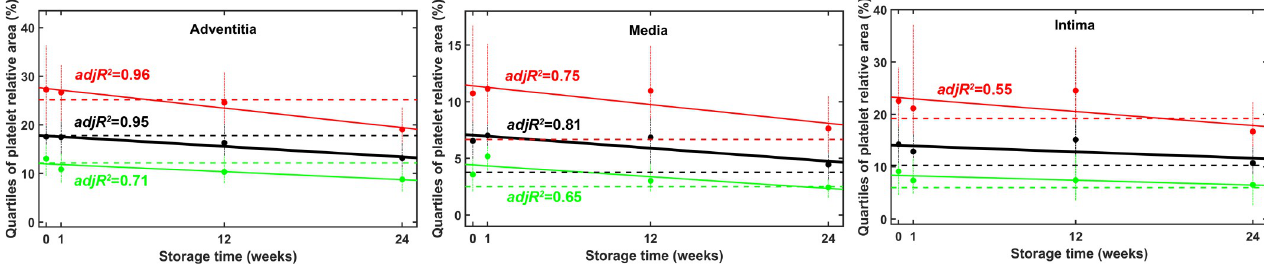
Fig 8. Time course of platelet adhesion to cryopreserved and native arterial allografts. Platelet coverage of the separate arterial wall layers was measured as illustrated in Fig 3. Lower (green), median (black) and upper (red) quartiles of the measured coverage data are shown with dashed lines for the BC, symbols for the cryopreserved samples and continuous lines for the linear regression performed as described in Materials and Methods. Error bars (vertical dotted lines) indicate the data spanning the range of 12.5% rank below and above the respective quartile value. The explanatory strength of the correlation can be assessed on the basis of the adjusted R 2 (adjR 2 ) values that are shown only for the regression trends proven to be significant at 0.05 level by the statistical approach described in Materials and Methods.